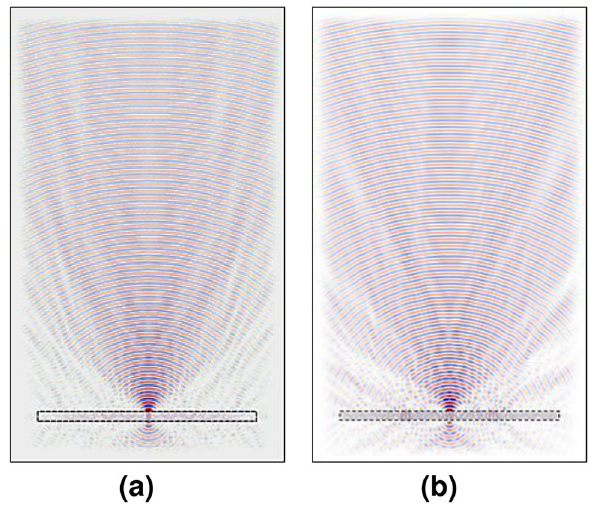
Figure 5. The optical image and the Meep results for 1 THz: ( a ) anisotropic wet etching. ( b ) Isotropic wet etching.